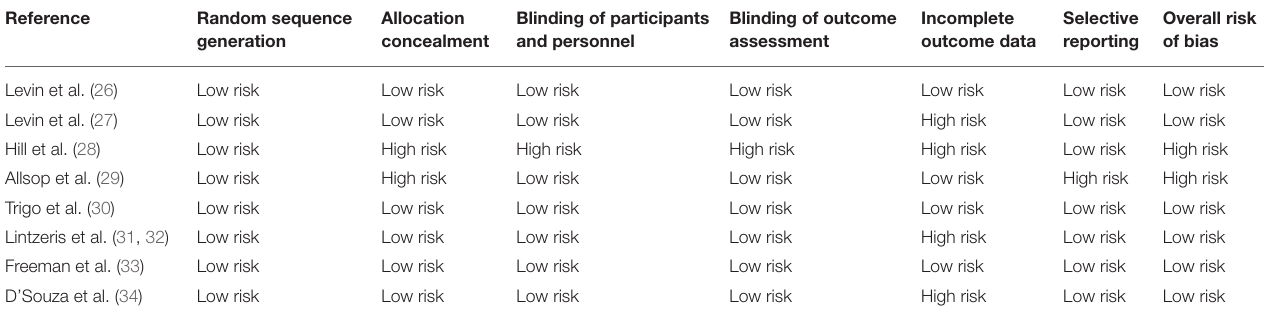
TABLE 1 | Risk of bias